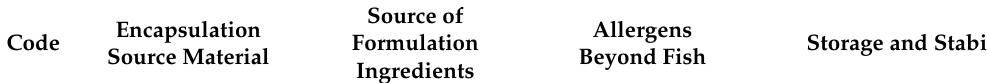
Table 2. DHA sources used in RUTF